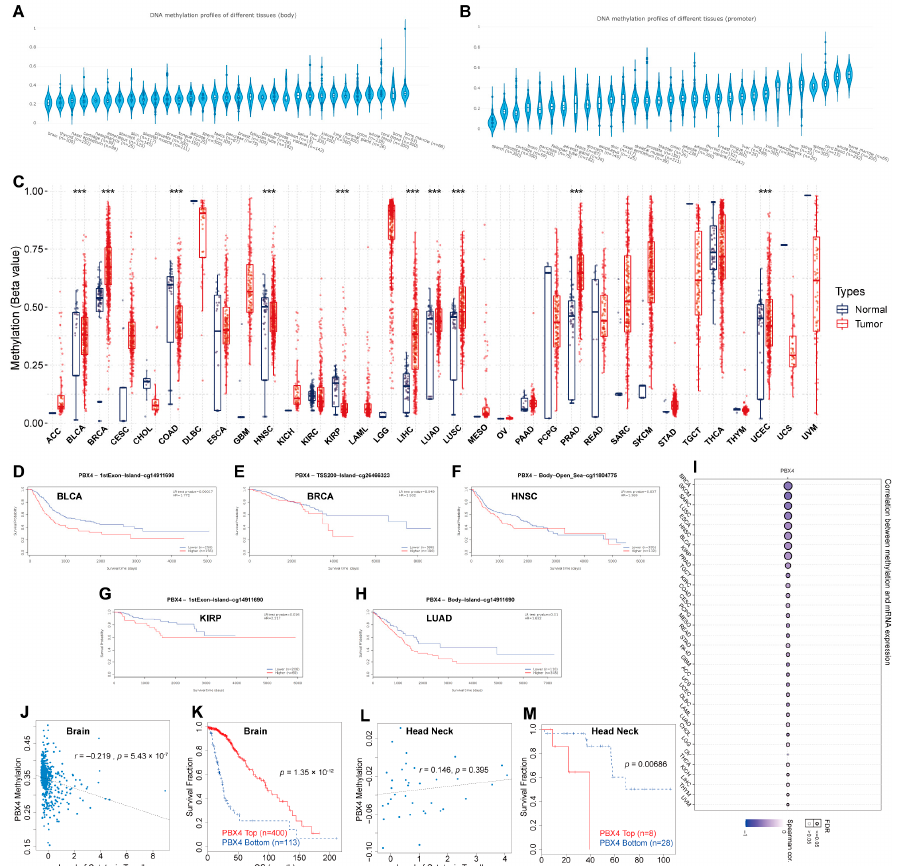
Figure 8. DNA methylation analysis of pan-cancer PBX4. PBX4 DNA methylation of ( A ) body and ( B ) promoter in human tissues. ( C ) The difference between PBX4 DNA methylation in cancer tissues and paired normal tissues (*** p < 0.001). The survival curves of PBX4 methylation for ( D ) CpG cg14911690 in BLCA, ( E ) CpG cg26466323 in BRCA, ( F ) CpG cg10738025 in HNSC, ( G ) CpG cg14911690 in KIRP, and ( H ) CpG cg11804775 in LUAD. ( I ) The correlations between methylation